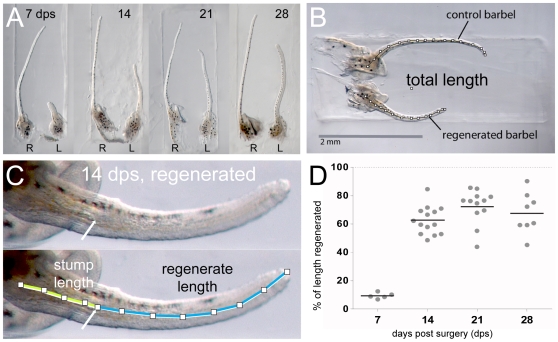
Barbel regeneration does not restore appendage length.
A) Four matched pairs of maxillary barbels collected 7–28 days post surgery and embedded in the wells of a DNA electrophoresis gel. R = right barbel (unoperated control); L = left barbel (regenerate). All regenerates are shorter than the contralateral appendages. Each panel is shown at the same magnification. B) Measurement of total length (TL). The total length of each barbel (segmented line) was measured from the base of the central rod to the distal tip of the appendage. C) Measurement of stump length (SL) and regenerate length (RL). Within each regenerating barbel, the stump was measured from the base of the central rod to the amputation plane. The regenerate length was measured from the amputation plane to the distal tip. Stump length + regenerate length = total length of the regenerating barbel (SL + RL = TL). D) The regrowth of each regenerate was calculated as a percent of the control (% of length regenerated = (regenerate length/(control length – stump length))*100). Most lengthening occurred 7–14 days post surgery. Longer periods of regeneration (21–28 days) did not yield statistically significant differences in length.